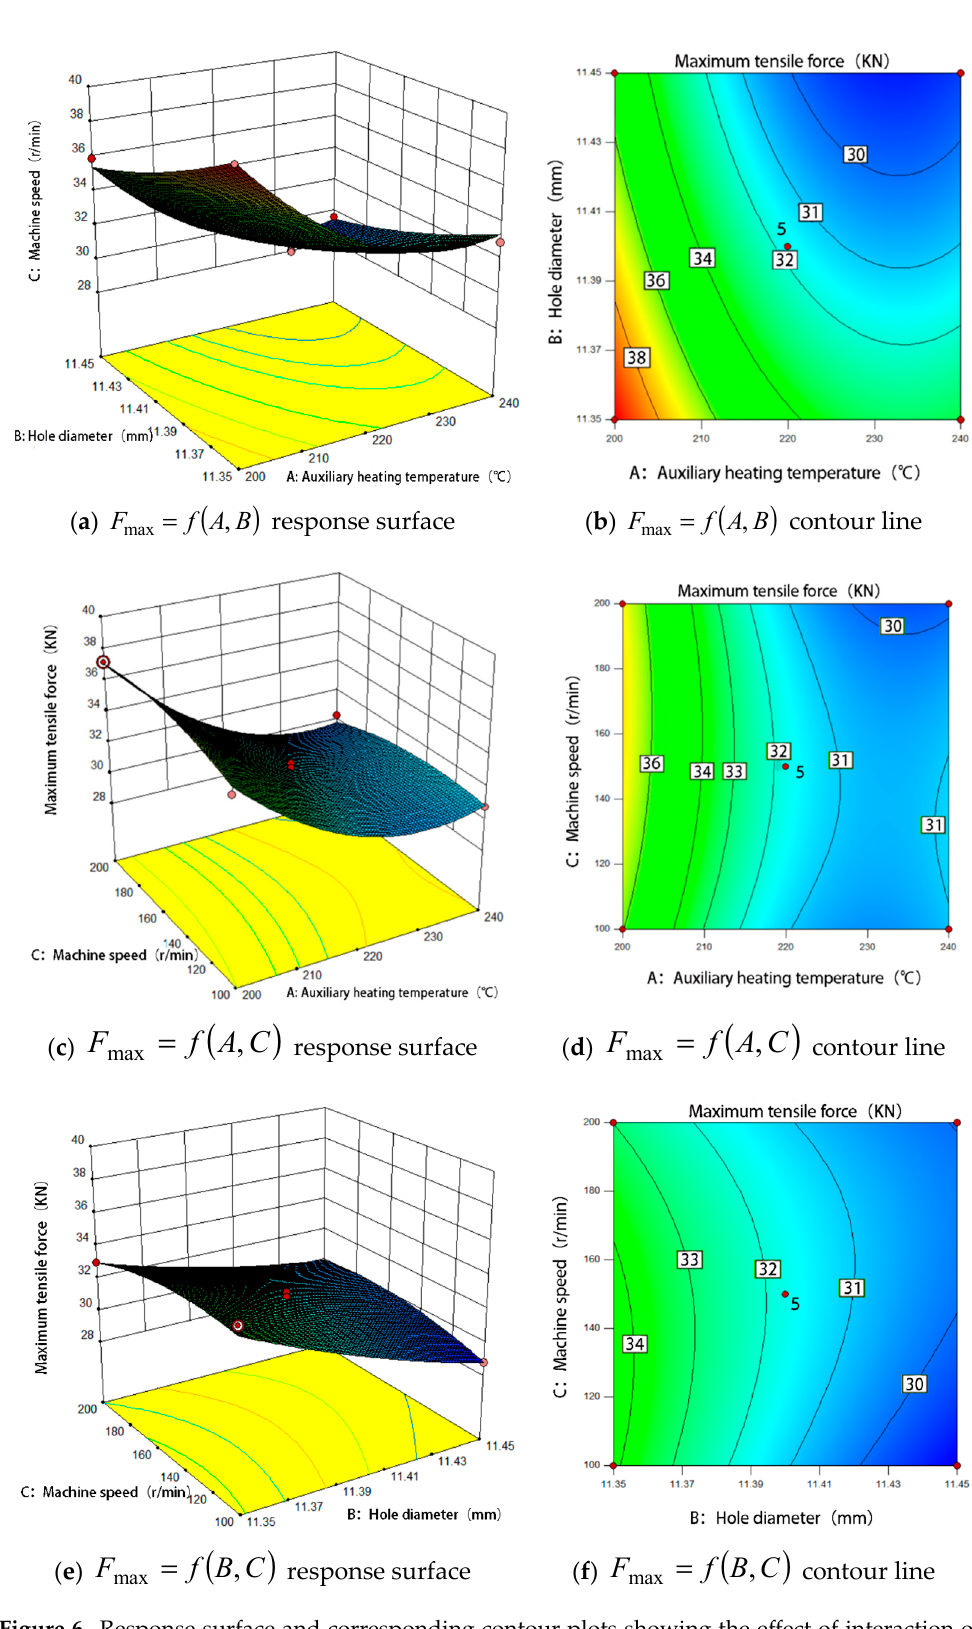
Figure 6. Response surface and corresponding contour plots showing the effect of interaction of various factors on the maximum tensile force.